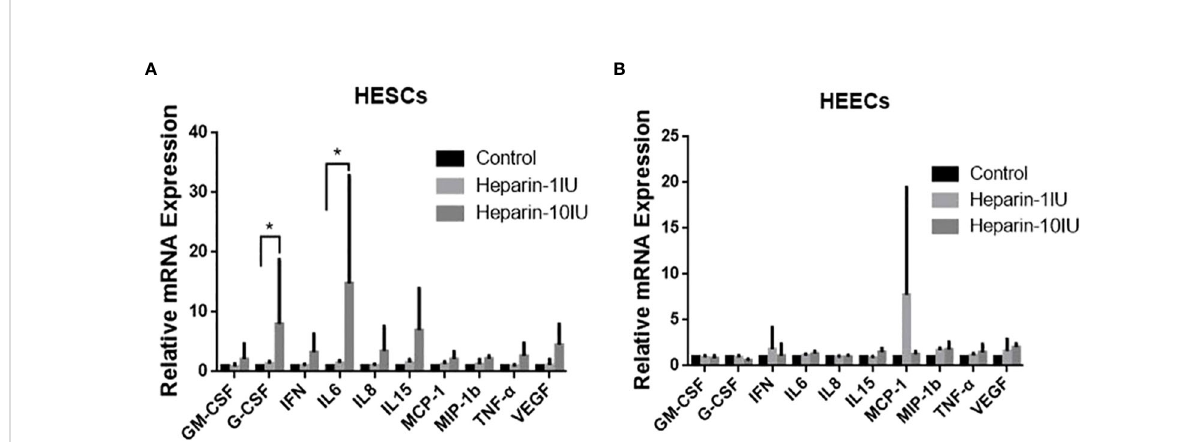
FIGURE 3 Cytokine mRNA levels are altered in HESC and HEEC incubated with LWMH for 48h. Data are presented as means ±SEM and *P<0.05. (A) Human endometrial stromal cells. (B) Human endometiral epithelial cells.